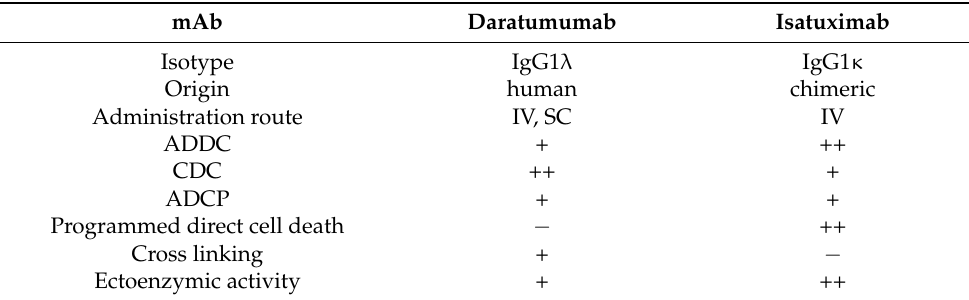
Table 1. Mechanisms of action in anti-CD38 monoclonal